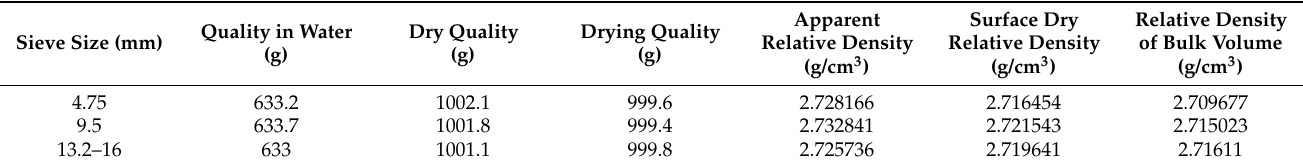
Table 1. The surface dry relative density of coarse aggregates.